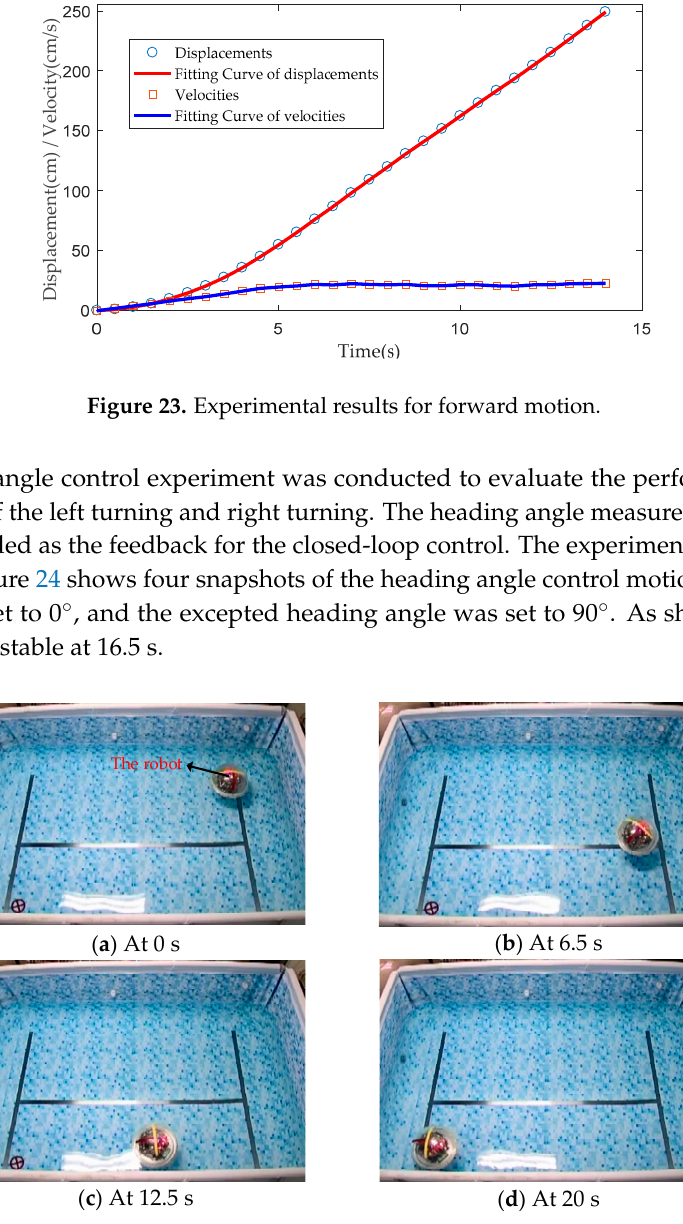
Figure 24. Heading angle control underwater motion on the water surface.